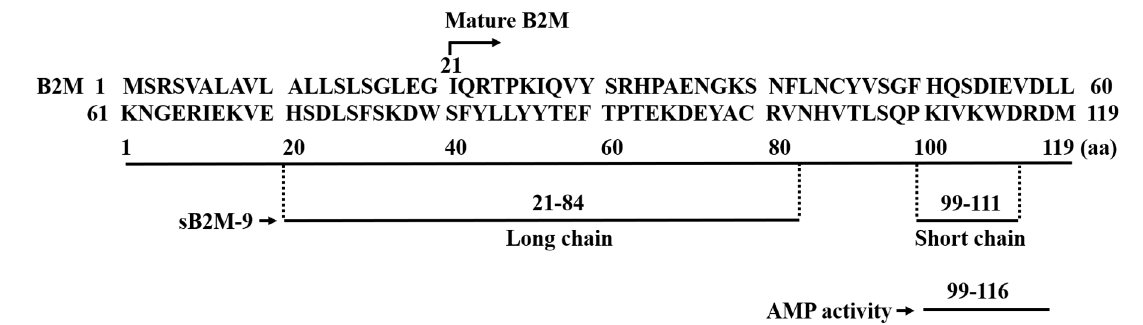
Figure 1. Diagram for the sequences of B2M and B2M-derived peptides with AMP activity. Mature B2M is a polypeptide of 99 amino acid residues (21-119). sB2M-9 [20] is composed of long chain (21–84) and short chain (99–111) amino acid sequences as indicated by a dashed line, cross-linking with a disulfide bond (not shown). Sequence 99–116 (theoretical pI = 10.06) with AMP activity [25] is shown in comparison with the short chain sequence (99–111, theoretical pI = 9.51) deduced from sB2M-9. One-letter code is used for the amino acid sequence of the peptide. Table 1. Shot-gun proteomic analysis of a panel of cationic polypeptides in a culture medium of REC. A549 cells, a type II alveolar epithelial cell line from human adenocarcinoma, were stimulated by Il-1 β (1 ng/mL) following a previous method [20] . MS/MS data were processed in MassLynx 4.0 software to obtain the Mascot search results. In addition to some im- mune response regulators, thioredoxin is notably indicated to involve a reduction process for short chain production.